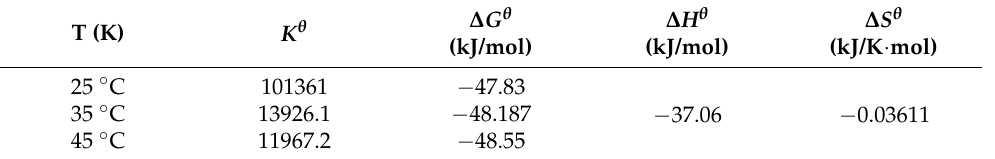
Table 4. Values of ∆ G θ , ∆ H θ , and ∆ S θ